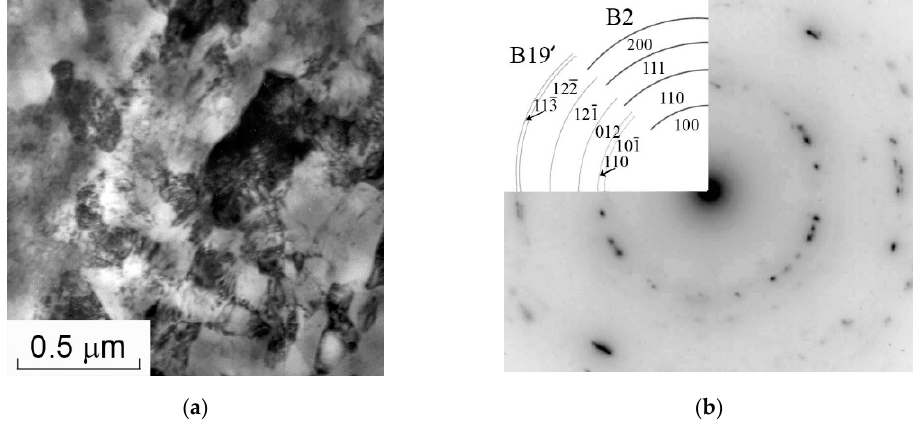
Figure 3. Structure of Ti 49.8 Ni 50.2 abc pressed to e = 8.44: ( a ) TEM image, ( b ) diffraction pattern.